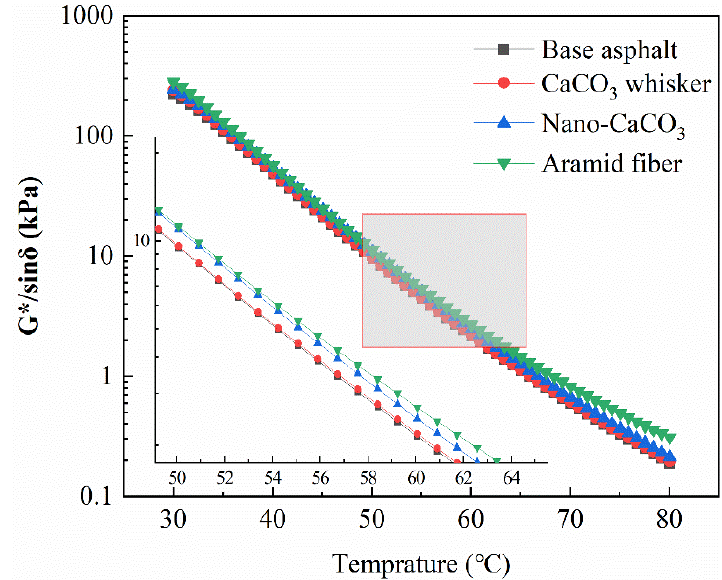
Figure 4. The rutting factors changes of various asphalt binders with temperature.